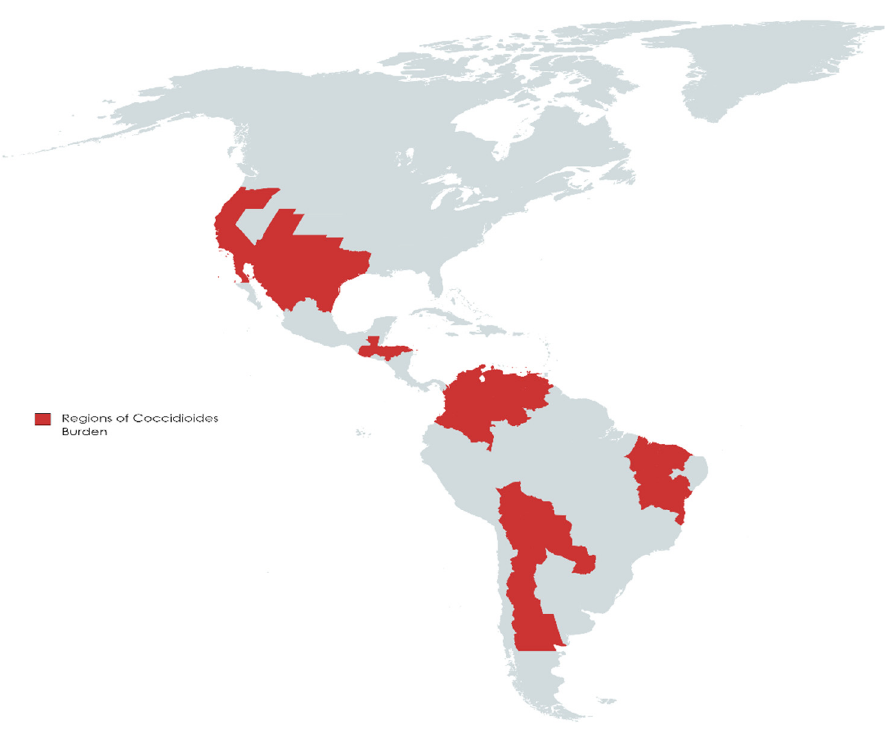
Figure 1. Regions of Coccidioides burden. Regions in North America have a longer history of surveillance than Central and South America. It is suggested due to the discrepancy that the impact of CM may be underestimated in Central and South America [5–7]. Figure created with MapChart.net.